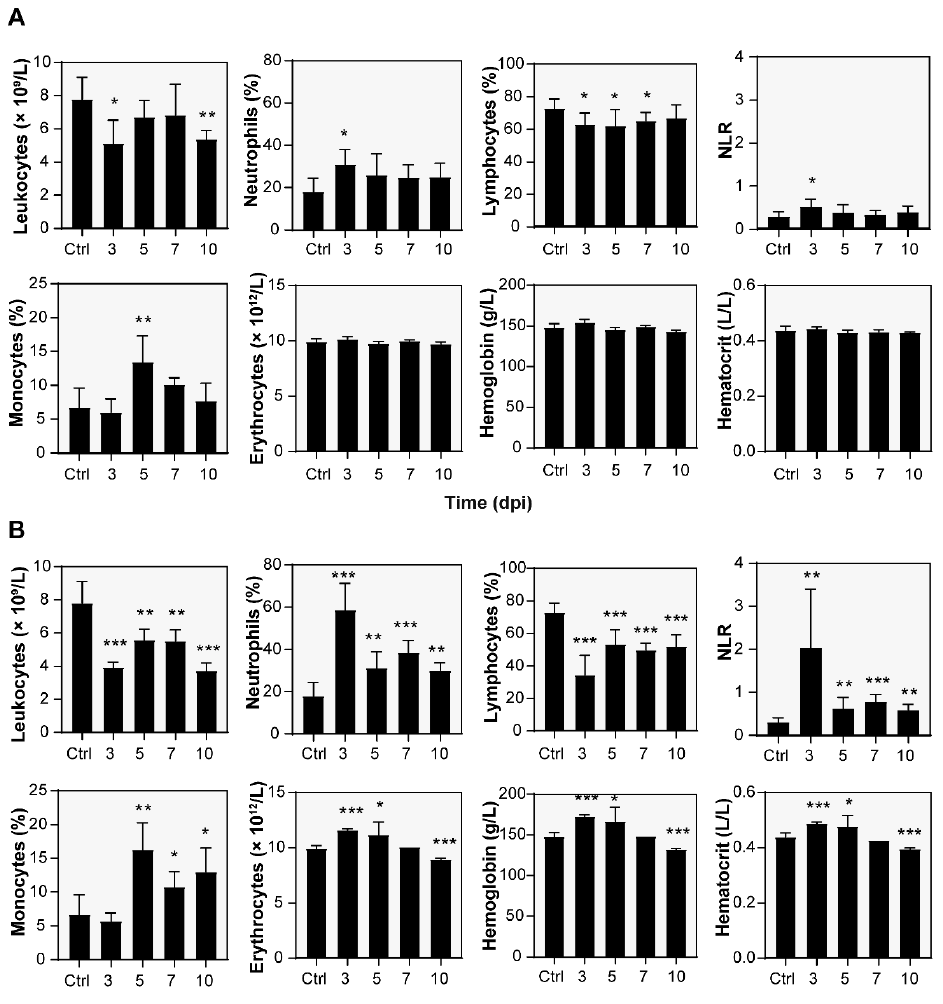
Figure 2. Selected parameters of the hematological analysis. Mice inoculated either with a low ( A ) or high ( B ) dose of L. pneumophila Sg 1, ST 62, or MAb Knoxville were anesthetized, and terminal blood collection was carried out. Data represent the mean ± SD; asterisks indicate statistical significance ((* p ≤ 0.05, ** p ≤ 0.01, and *** p ≤ 0.001) compared with the control (Ctrl, noninfected animals). The neutrophil-to-lymphocyte ratio is abbreviated as NLR.